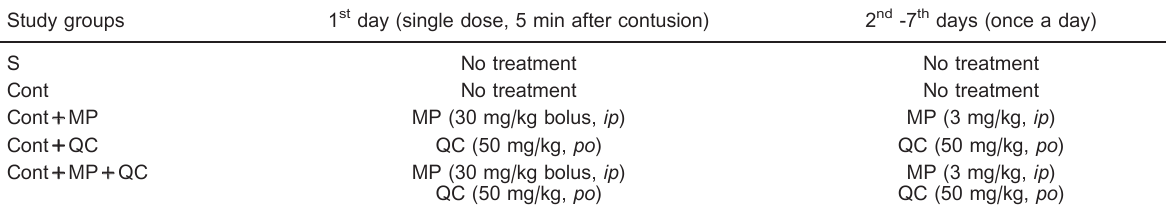
Table 1. Treatment protocols in the study groups. Study